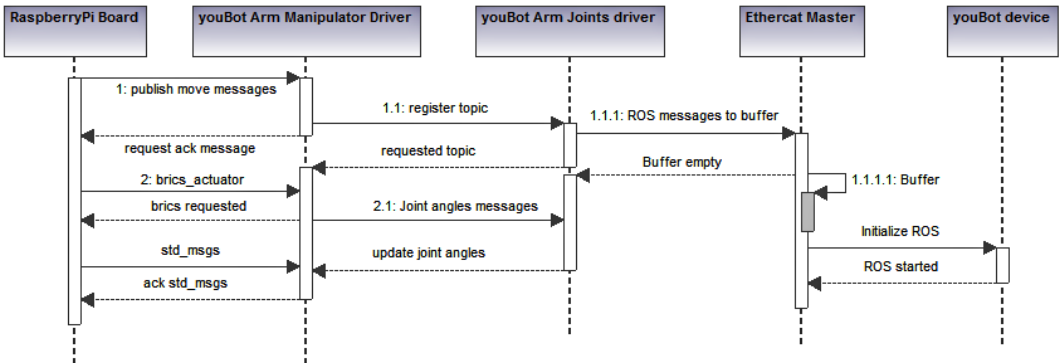
Figure 8. Sequence flow diagram between RPI and ROS into Kuka